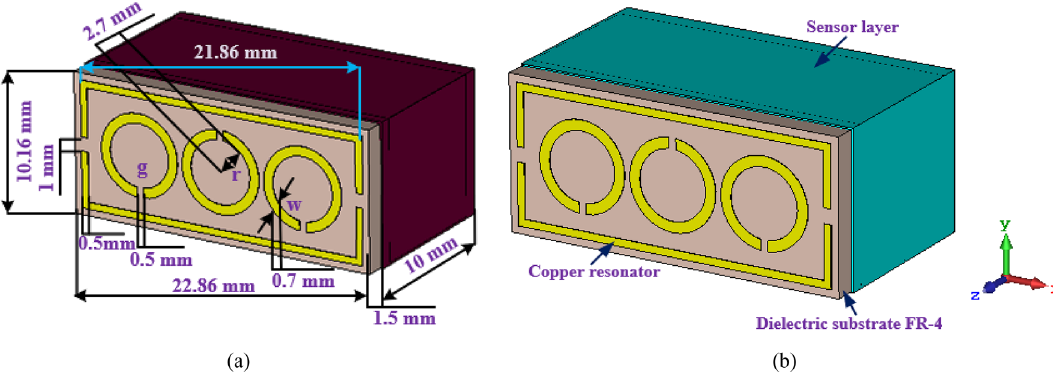
Figure 1. ( a ) Main construction with sizes, ( b ) perspective position of the MTM-based sensor. (CST STUDIO SUITE 2019, https:// www. 3ds. com/ produ cts- servi ces/ simul ia/ produ cts/ cst- studio- suite) 50 .